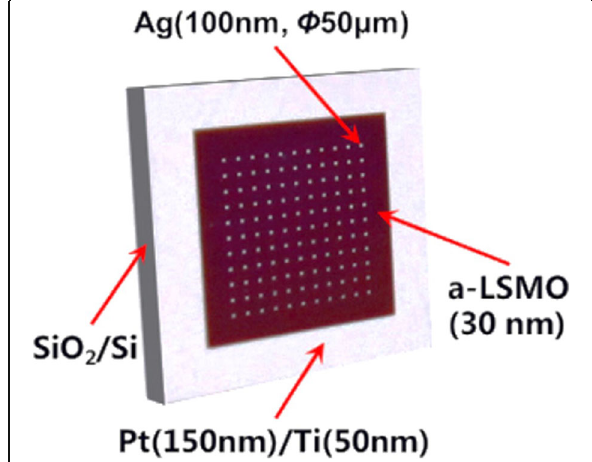
Fig. 41 Schematic of the Ag/La 0.79 Sr 0.21 MnO 3 ( a -LSMO)/Pt memory device. Reproduced with permission of